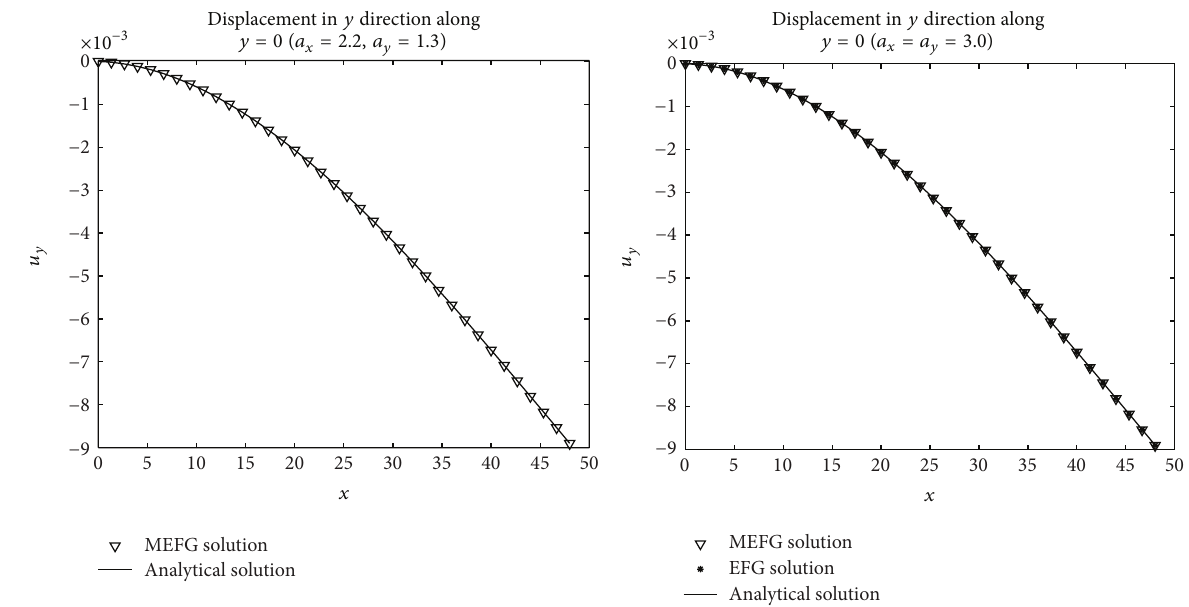
Figure 4: Comparison of displacement 𝑢 𝑦 along 𝑦 = 0 between analytical and numerical solution.